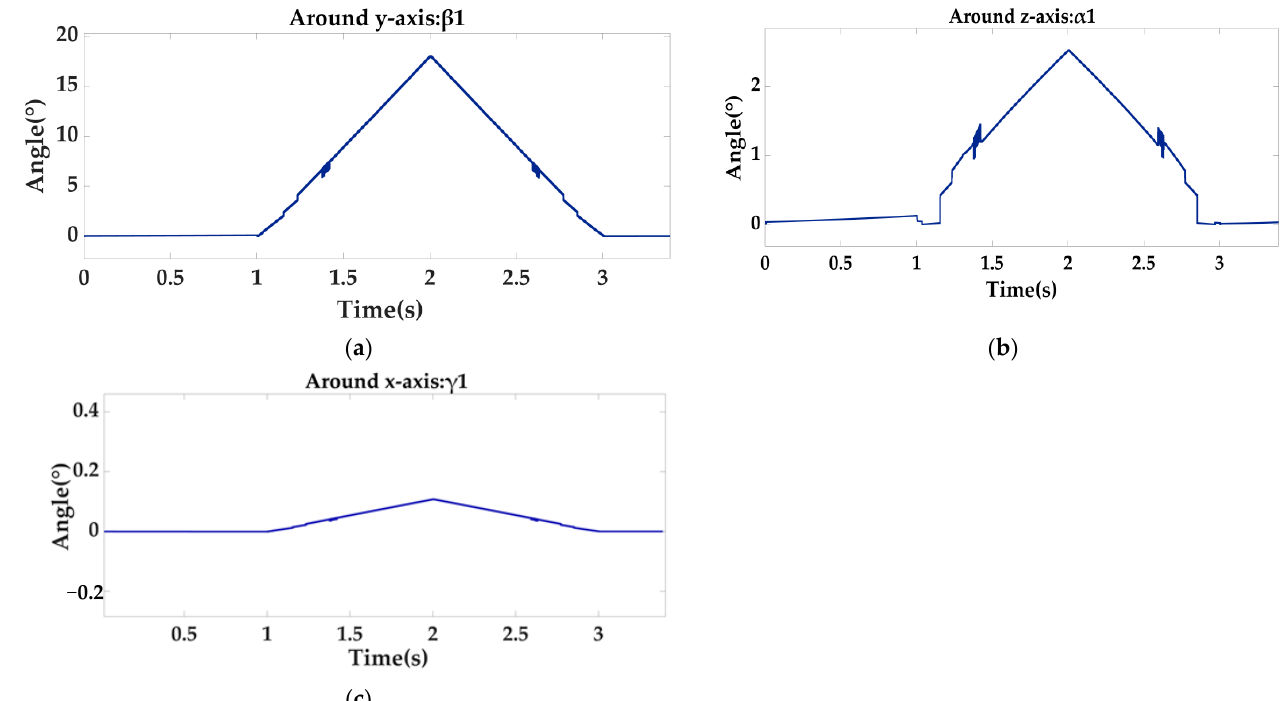
Figure 12. Euler angle diagram measured by vision sensor, rotated 15 ◦ around the y-axis, where ( a ) is